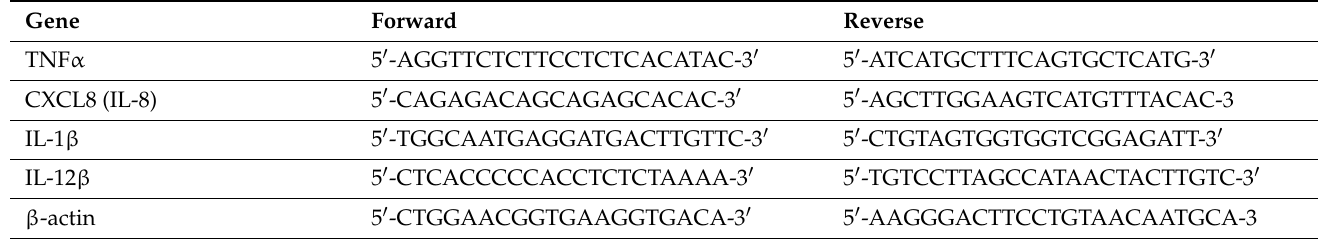
Table 1. Primers for